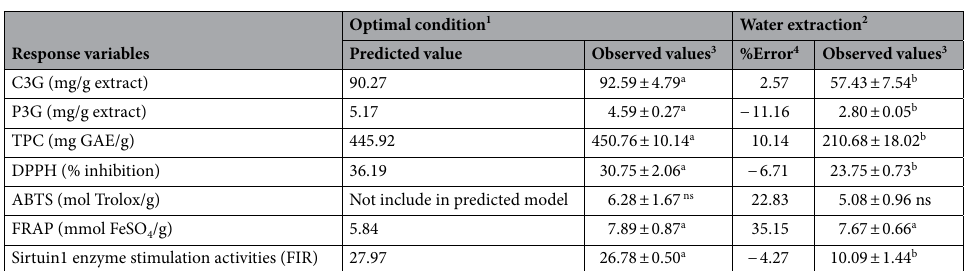
Table 4. Validation of optimal condition of PEF-AWE process. 1 Calculated using the predicted equations for response variables. Given optimal condition of independent variables as intensity of electric field 5 kV, number of pulse 3000 pulse and ratio of BRG and water 0.5 g/mL. 2 Distilled water, 6 h extraction time, 25 °C extraction temperature and ratio of BRG and water 0.5 g/mL. 3 Means of three replicates experimental (mean ± SD). 4 %Error = [(observed values − predicted value)/predicted value] × 100%. a,b Values within the same row with different superscript letters are significantly difference and. ns Indicated non-significant difference of observed values of optimal PEF-AWE condition and water extraction at p <